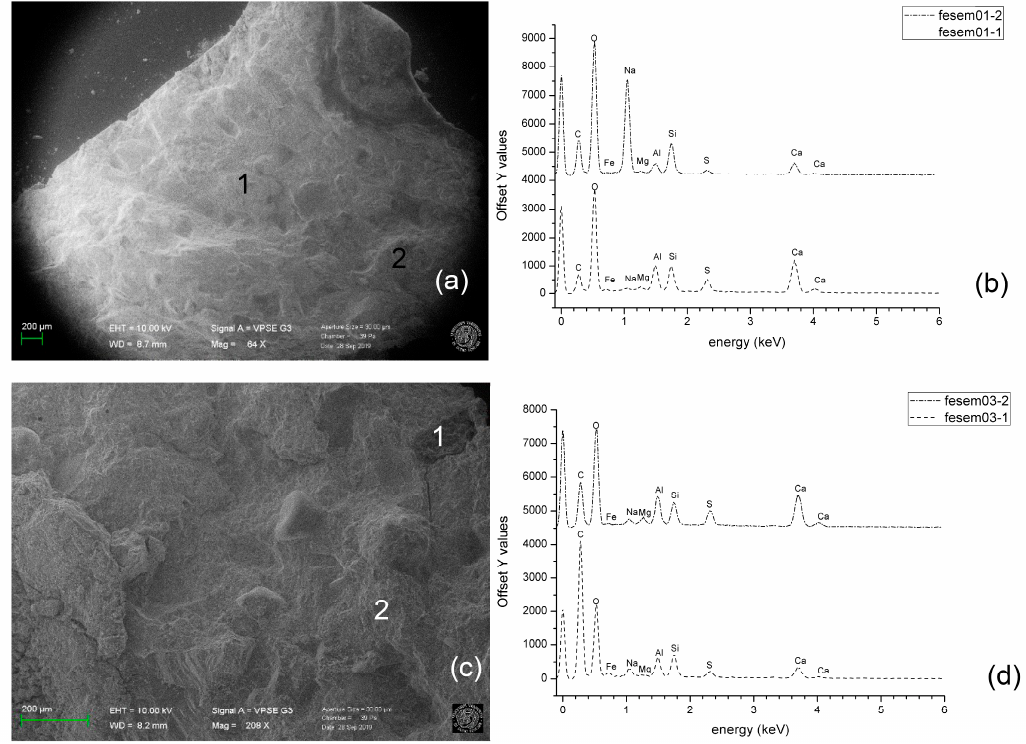
Figure 15. ( a ) SEM image of fragment collected along the crack surface after the first healing cycle; ( b ) EDS at point 1 and 2; ( c ) SEM image of fragment collected along the crack surface after the third healing cycle; ( d ) EDS at point 1 and 2. healing cycle; ( d ) EDS at point 1 and